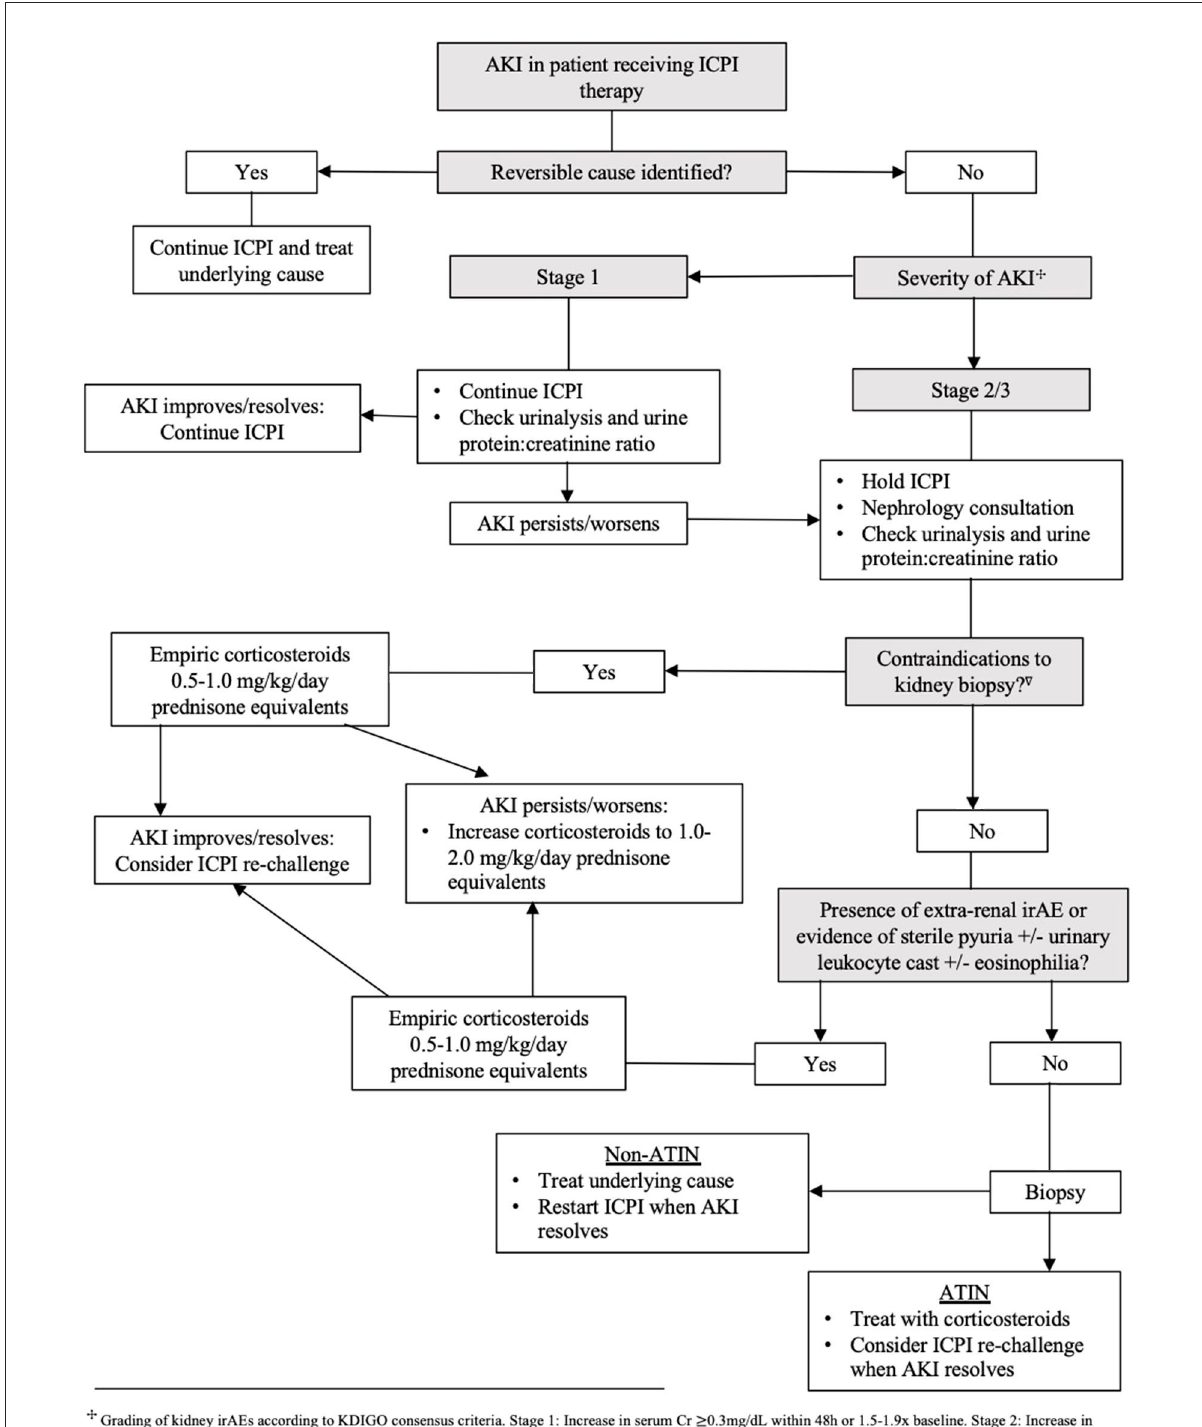
FIGURE1 Evaluation and initial management algorithm for suspected